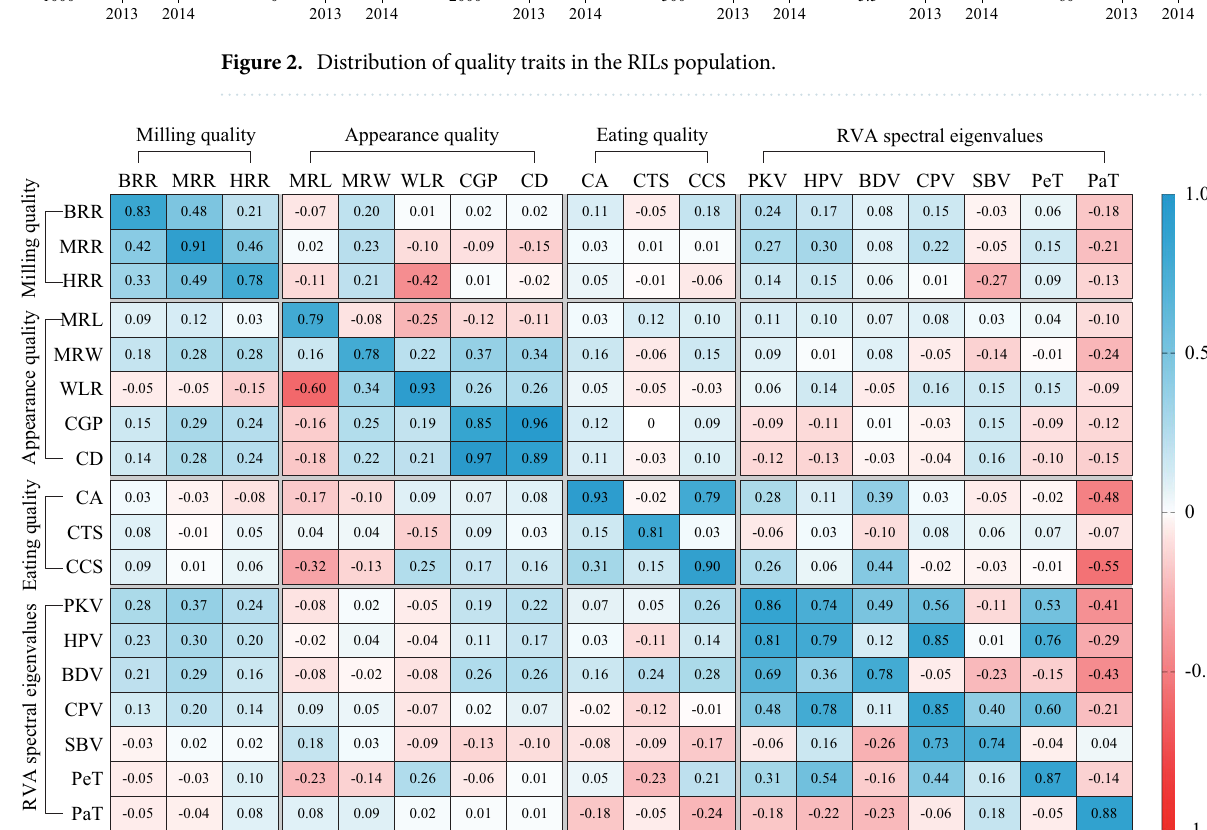
Figure 3. Pearson correlation coefficient to analyze the relevance on RILs Quality-related traits. The lower triangle indicates the correlation coefficient for 2013, the upper triangle indicates the correlation coefficient for 2014, and the diagonal data indicates the correlation coefficient between two years for the same